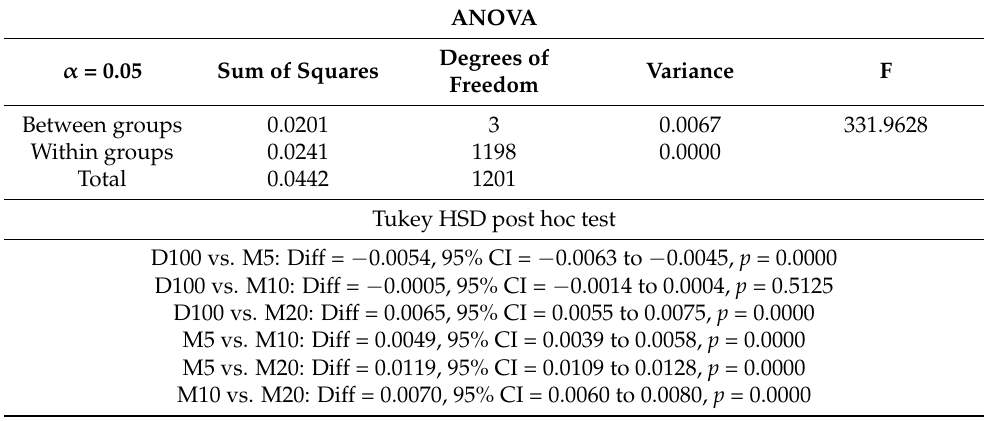
Table 13. Results of ANOVA with Tukey HSD post hoc test for CH 4 at the measurement point 1.